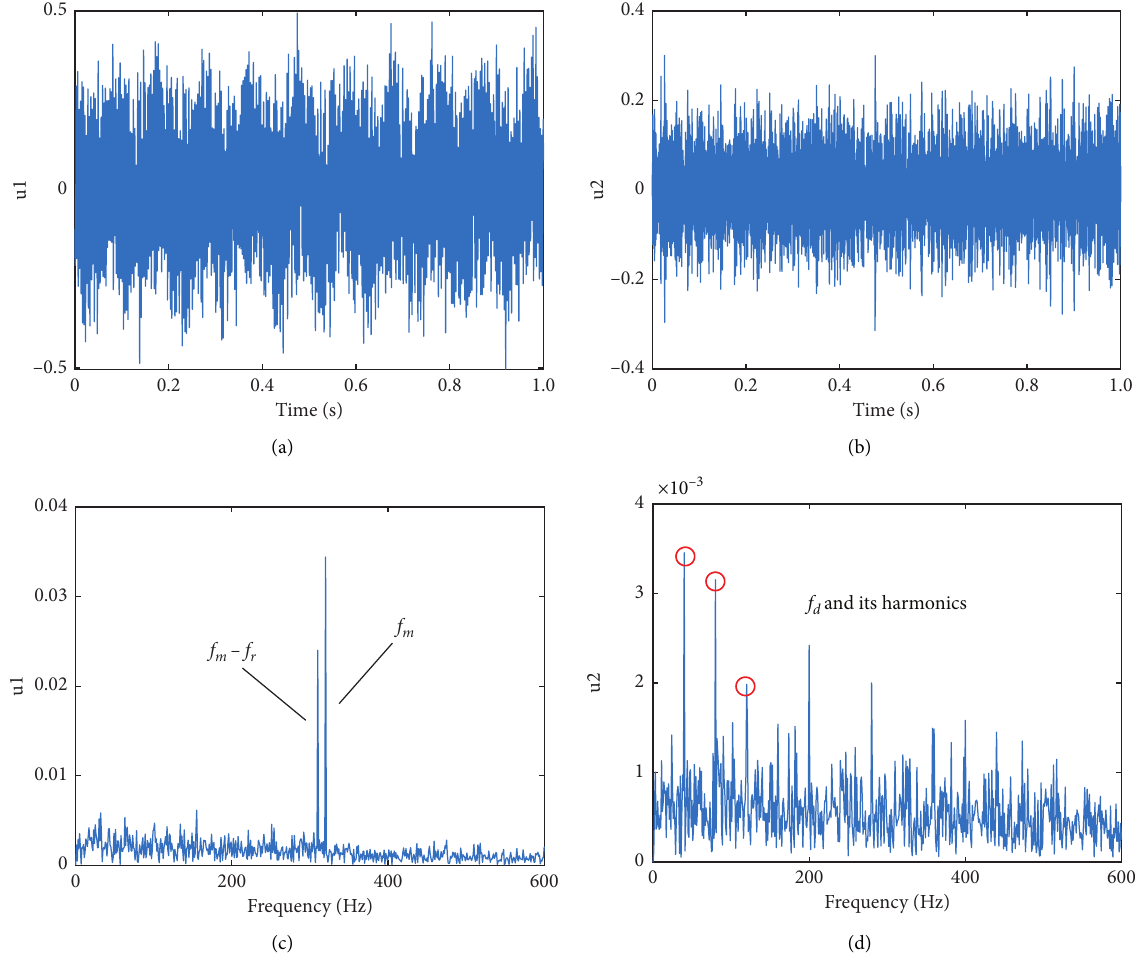
Figure 9: Simulated signals of case 1: signal processing results based on PAVMD: (a, b) time-domain waveform of each mode and (c, d) the corresponding squared envelope